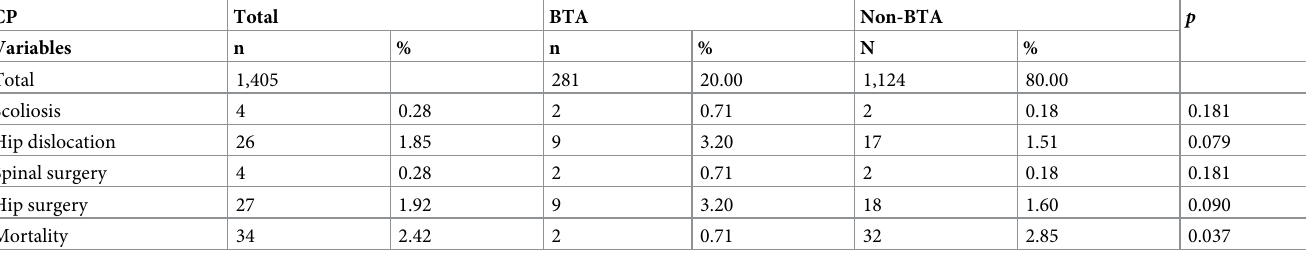
Table 3. Characteristics of the study population at the endpoint.